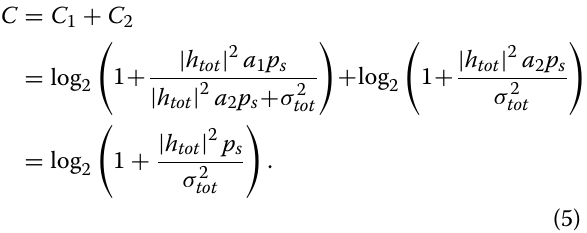
In (3), α 1 h 1 h 6 x s [ n − 1] is the desired signal to be recov- ered, α 1 h 6 η 1 [ n − 1] + η d [ n ] is the additive noise at the des- tination, and the term α 1 h 3 h 6 x 2 [ n − 1] is the interference from relay 2 which should be canceled or